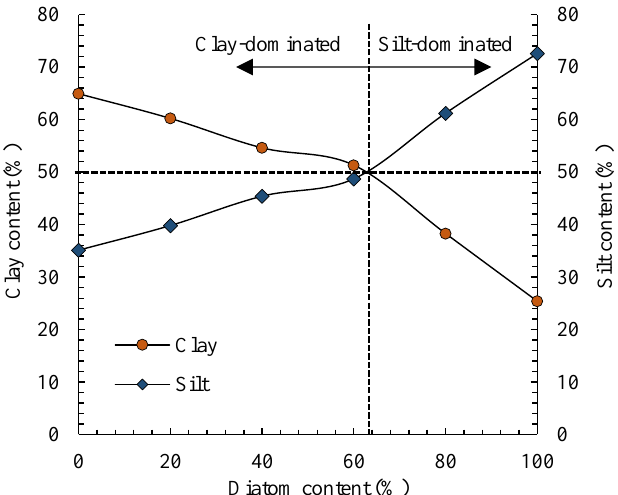
Figure 13. Variations of silt and clay particle contents of DKM samples with diatom content.